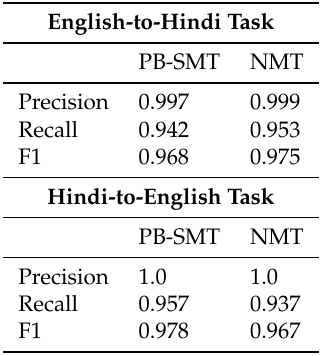
Table 7. TermEval’s performance on terminology translation evaluation